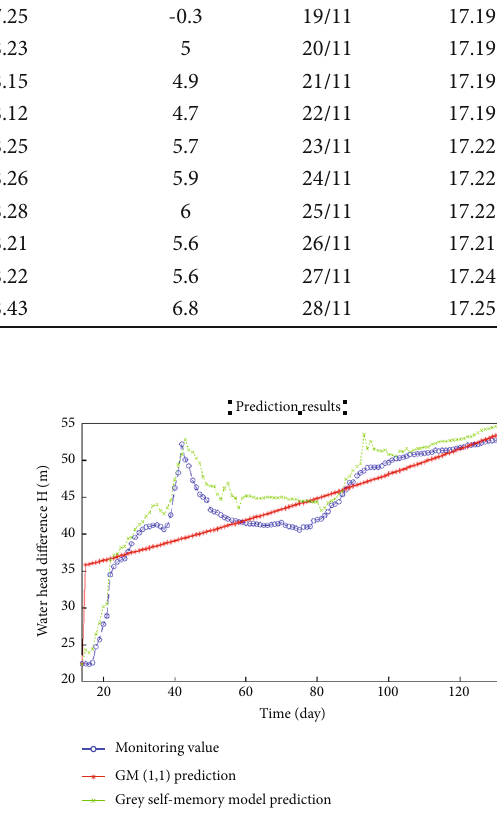
Figure 9: The comparison of prediction value and monitoring value at the point